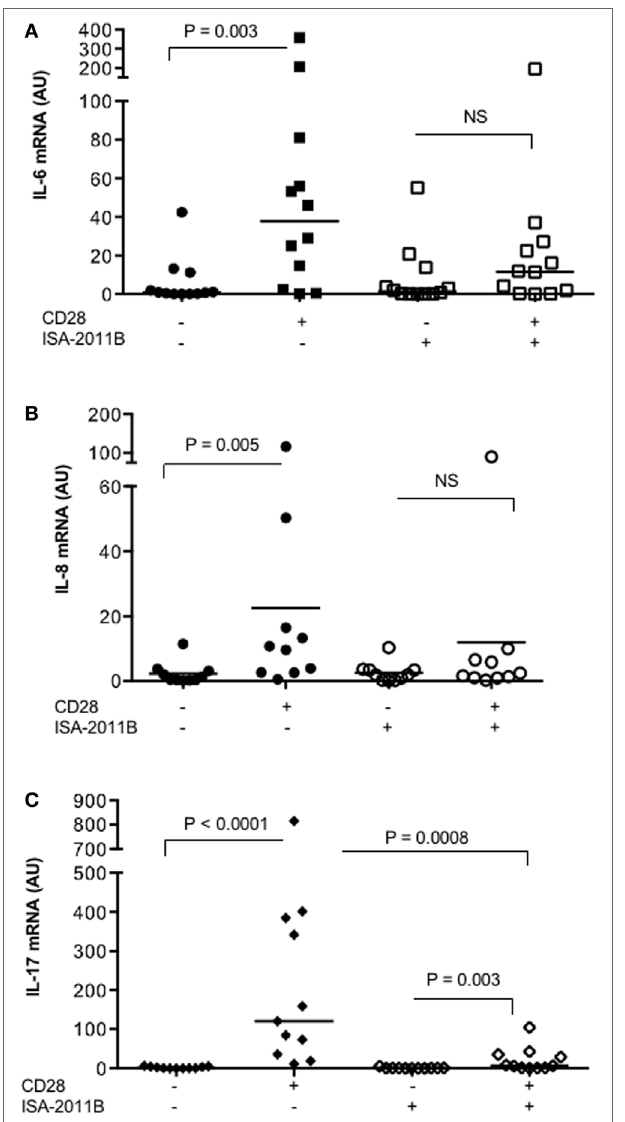
FigUre 5 | isa-2011B impairs cD28 autonomous signals inducing the expression of pro-inflammatory cytokine/chemokine . Primary T cells from healthy donors subjects ( n = 12) were treated with DMSO or ISA-2011B (10 µM) and stimulated for 6 h (a,B) or 24 h (c) with control isotype-matched mAb or crosslinked anti-CD28.2 Abs. IL-6 (a) , IL-8 (B) , and IL-17A (c) mRNA levels were measured by real-time PCR and values, normalized on GAPDH, expressed as arbitrary units. Median values: IL-6, DMSO = 0.89, DMSO CD28 = 37.66, ISA-2011B = 1.33, ISA-2011B CD28 = 11.66; IL-8, DMSO = 0.9, DMSO CD28 = 10.19, ISA-2011B = 1.9, ISA-2011B CD28 = 2.0; IL-17A, DMSO = 0.76, DMSO + CD28 = 120.4, ISA- 2011B = 0.69, ISA-2011B CD28 = 7.0. Lines represent median values and P values are indicated where significant (Mann–Whitney). NS = not significant.